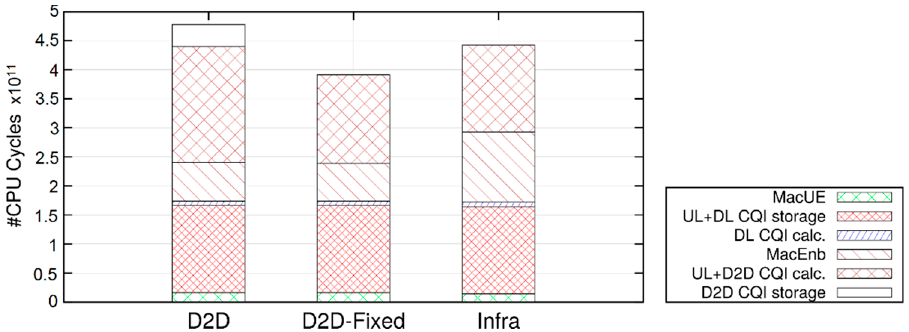
Figure 17. Breakdown of execution times with 10 UE pairs, 0.1 s inter-packet time (leftmost bars in Figure 16).